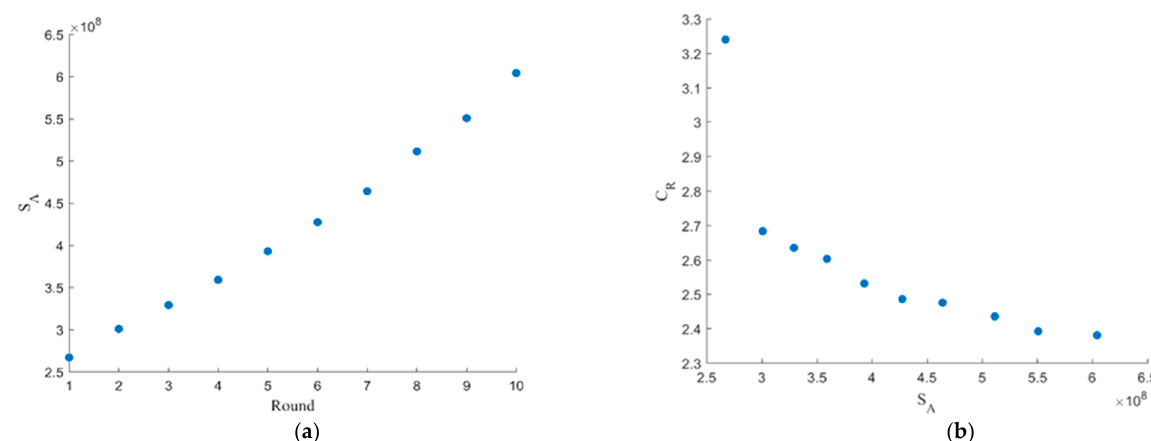
Figure 9. Scatters plot of m rounds compared to the S A value of the encrypted DEM A and that of C R compared to the S A values.